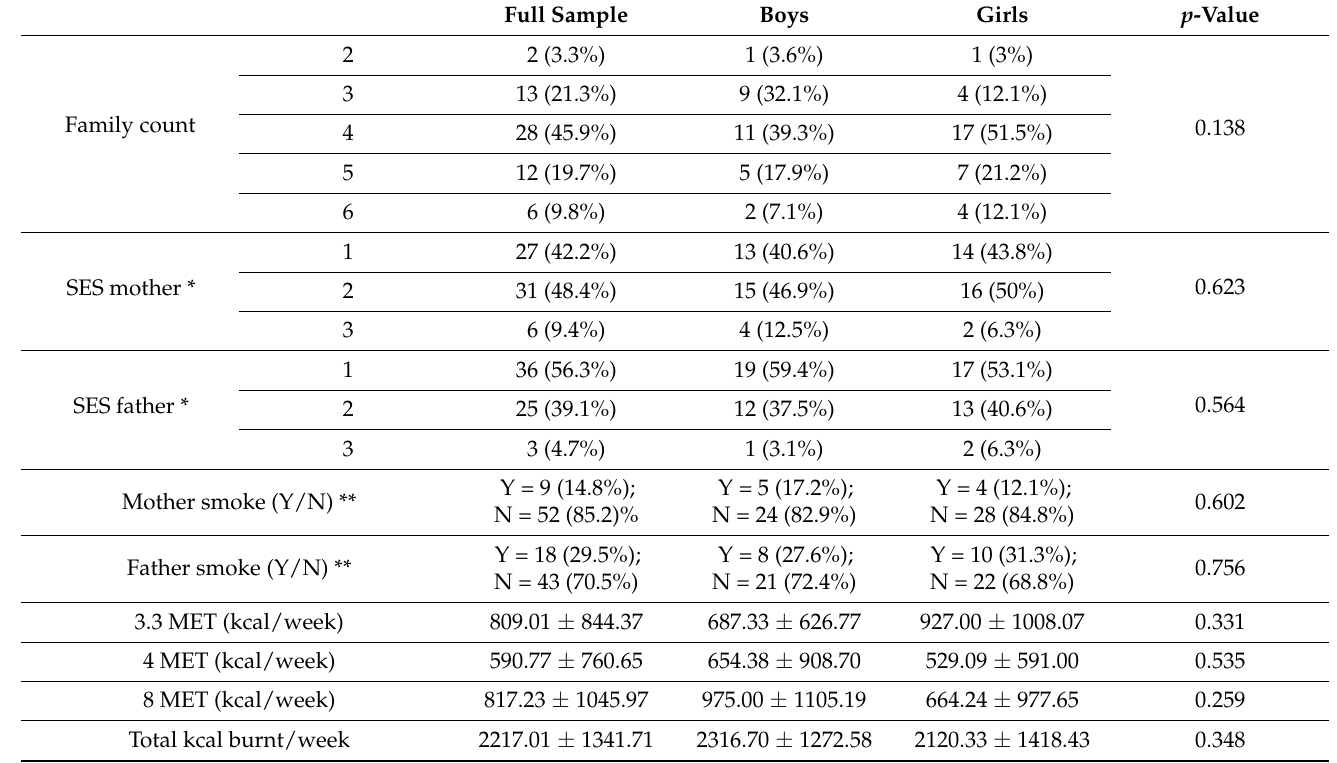
Table 3. IPAQ-A global assessments and other non-nutritional aspects of sample. Full